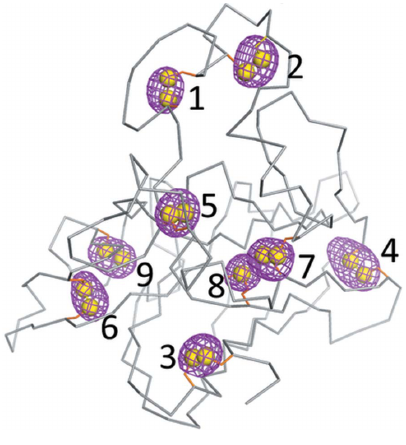
Figure 1 Anomalous difference peaks identified in thaumatin from the S-SAD data.. Reproduced from Guo et al.